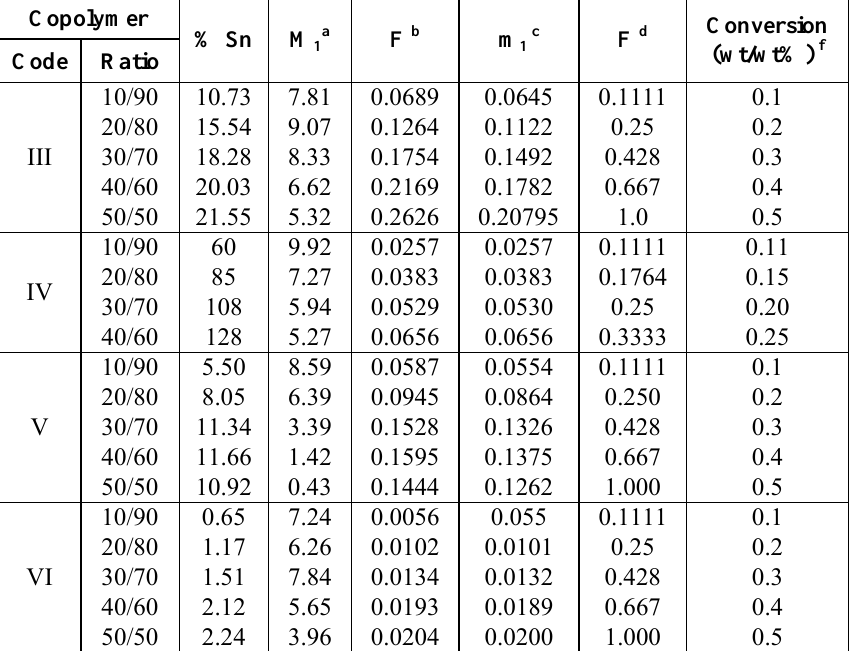
Table 3. The composition parameters of copolymers III–VI .